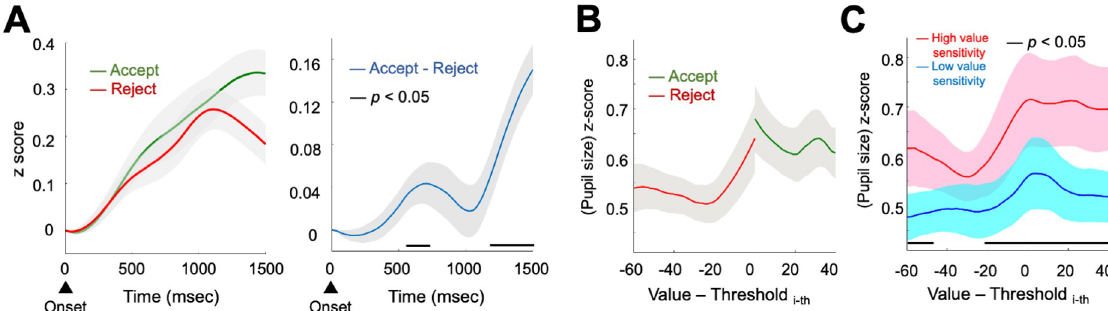
Fig 5. Pupillometry responses reflect subsequent choices and decision values. (A) Pupil size change from the stimuli onset was measured, separately for the accepted (green) and rejected (red) opportunities. Paired comparison between the cases revealed significant pupil dilation for the accepted stimuli at the early stage after the onset, and again at the later time. (B) To examine whether or not pupil size reflected stimuli value, the peak pupil size between the stimuli onset and 1500 msec after the onset was depicted as a function of the signed distance between stimuli value and the corresponding decision threshold. (C) Individuals who had higher value sensitivity in their estimated parameter (median split; red) showed more pronounced pupillometric responses reflecting the value information. Shades represent s.e.m.